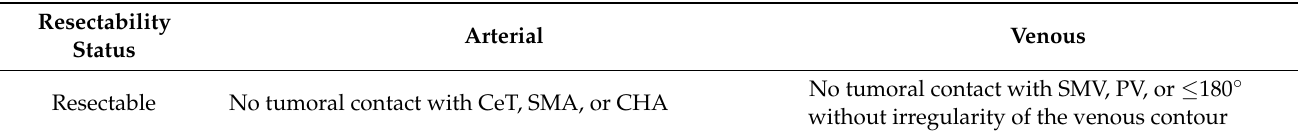
Table 1. Definition criteria of resectability by NCCN v 1.2019.